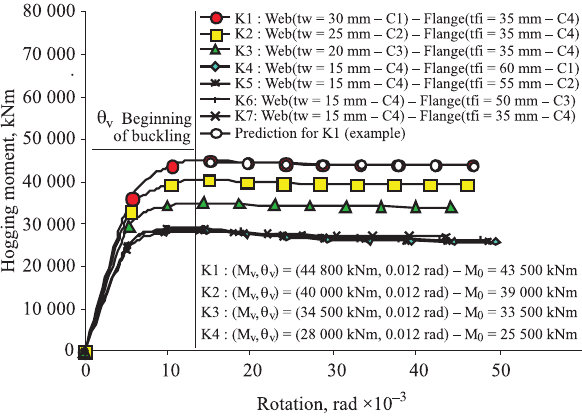
Fig. 12. 3D calculations and buckling curves – class